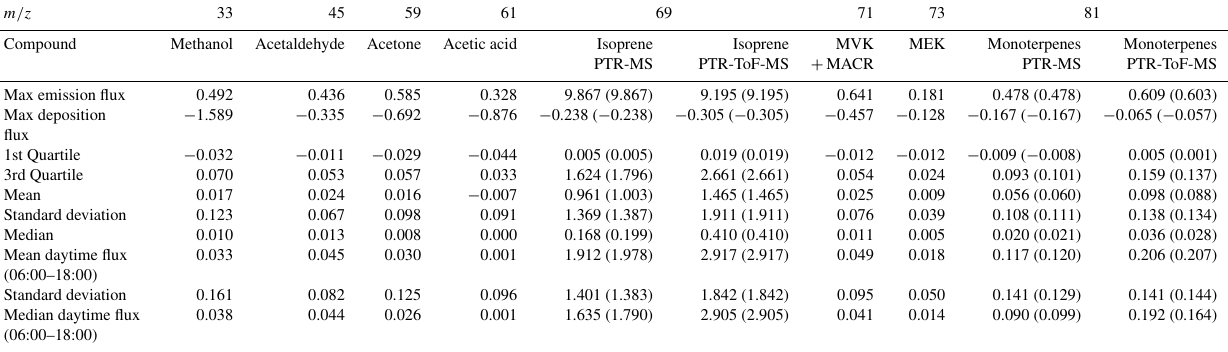
Table 3. Summary of the BVOC fluxes (mgm − 2 h − 1 ) recorded during the Bosco Fontana field campaign based on 25min values. Values in brackets cover the campaign period where data are available from both instruments to enable direct comparison (15 June–6 July and 15–25 June 2012 for isoprene and monoterpenes